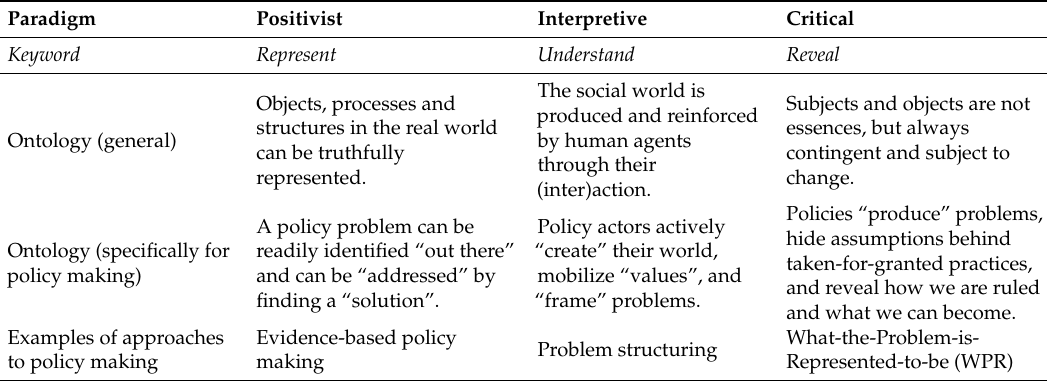
Table 1. Ontology and examples of policy making approaches for each